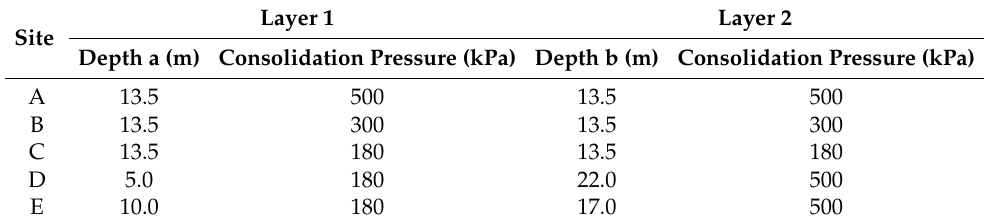
Figure 9. Setup for the centrifuge test (after [16]). Table 5. Five site conditions used in the test (after [16]).